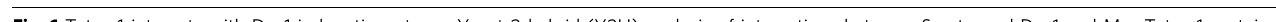
Fig. 1 Tctex-1 interacts with Dsg1 in keratinocytes. a Yeast 2-hybrid (Y2H) analysis of interactions between Sos-tagged Dsg1 and Myr-Tctex-1 protein. Growth on galactose (GAL) at 37 °C indicates an interaction. Incubation on glucose (GLU) at 25 °C represents a permissive growth condition,